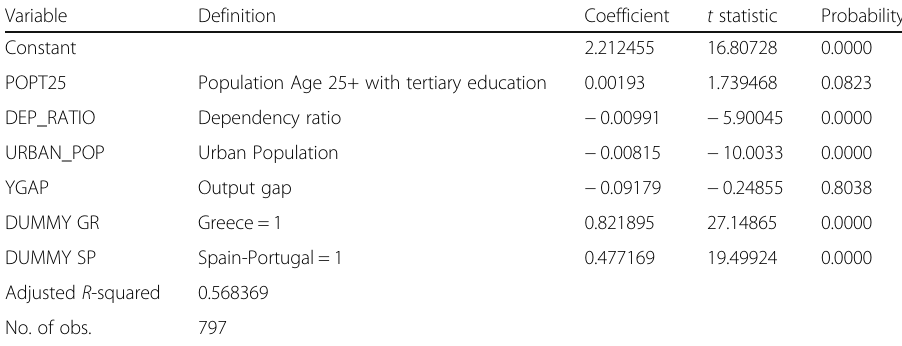
Table 5 WPR vs demographic factors and the state of the business cycle variables with country dummies